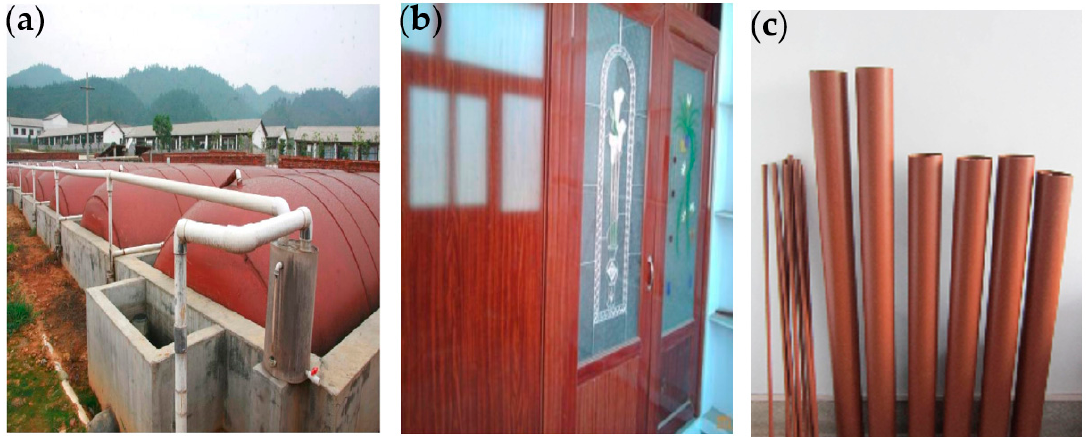
Figure 10. Various RM plastic used in different areas (( a ) biogas fermentation tank; ( b ) plank; ( c )